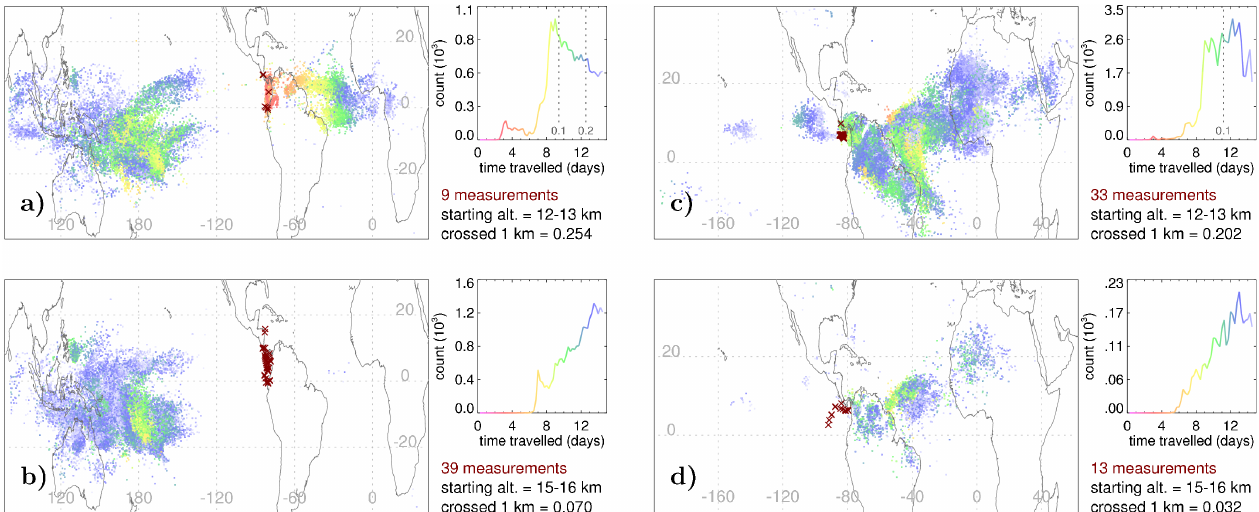
Fig. 12. On the left of each plot, maps of trajectory 1km crossing locations during CR-AVE (a, b) and TC4 (c, d) . 10000 back trajectories start at each sample location (dark red crosses) in the following altitude bands: in (a) and (c) trajectories start between 12–13km, in (b) and (d) between 15–16km. Refer to Fig. 1 for additional